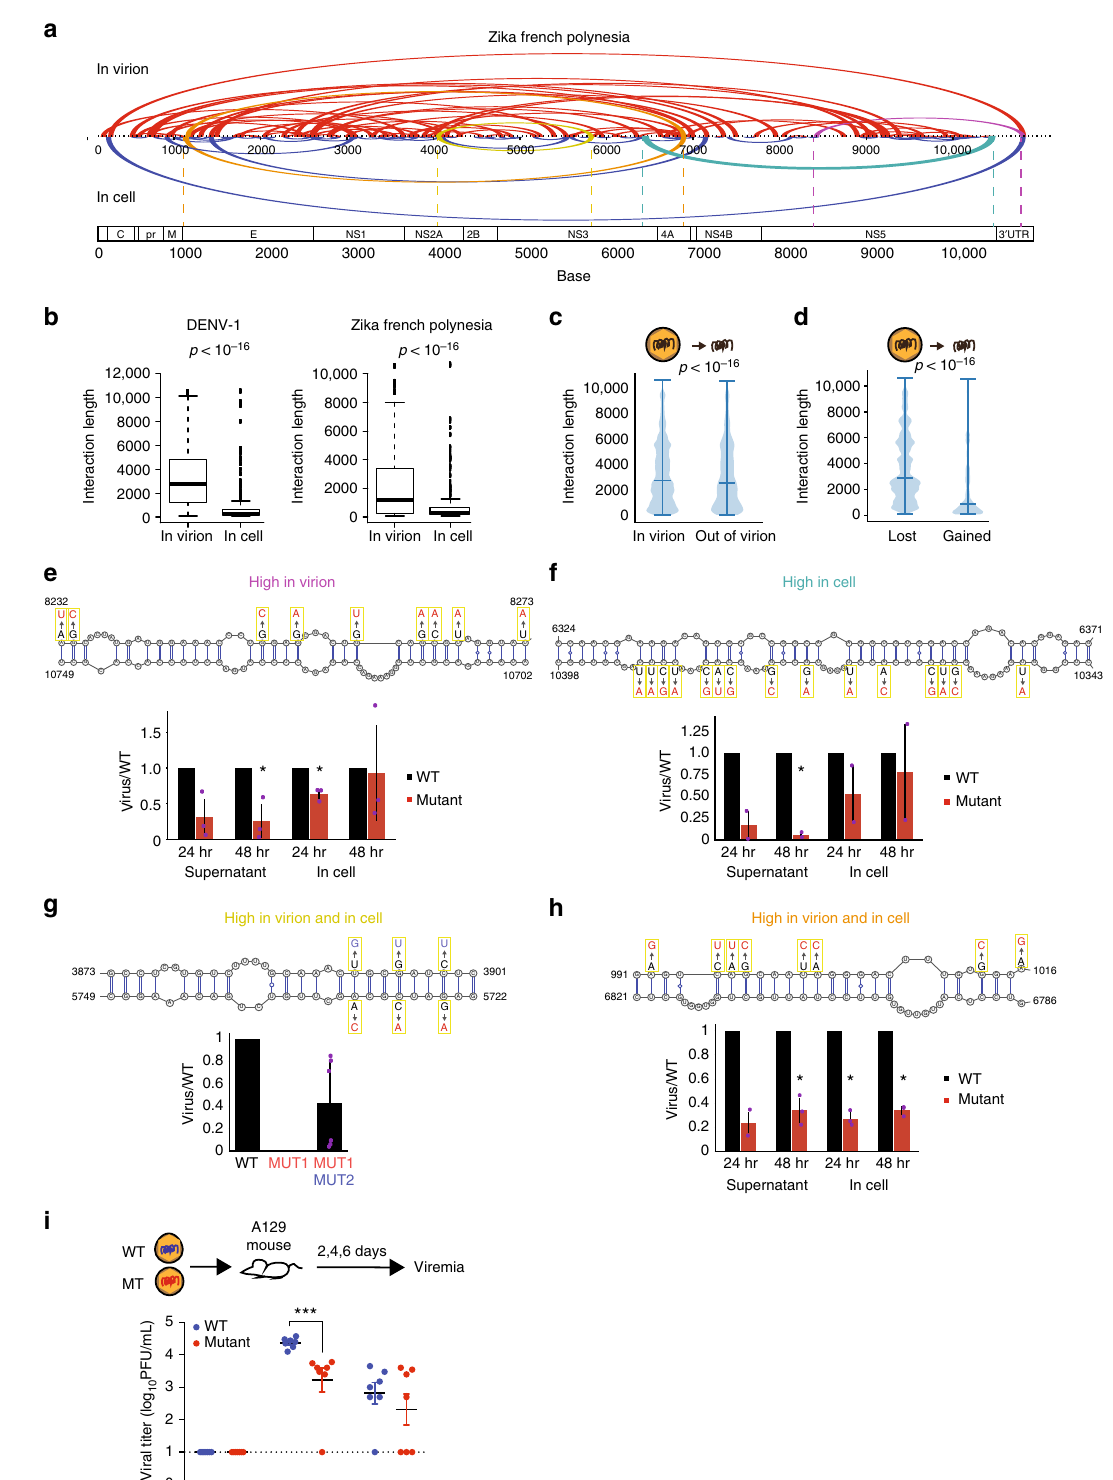
cell and in virion, disrupting the pairing between E and NS4A coding regions (Fig. 5h). To show that the mutations attenuate virus replication, we injected wild-type and mutant virus into interferon-de fi cient A129 mice and checked for viremia 2 – 6 days post infection. Mutant virus resulted in lower virus titers in